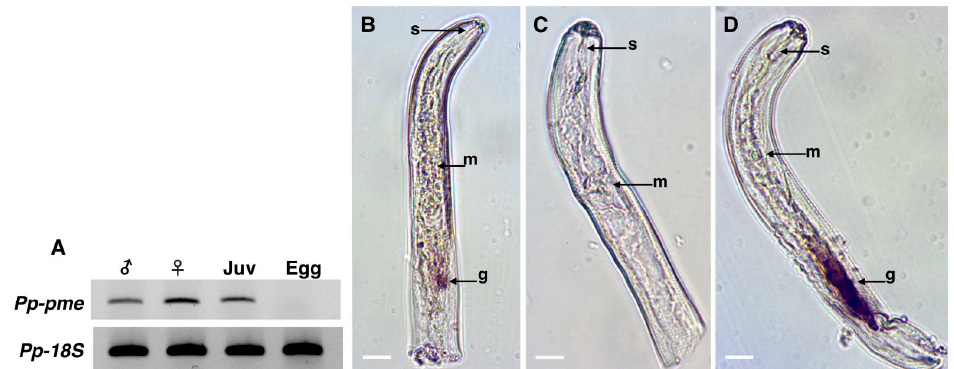
Fig 5. Expression and localization of Pratylenchus penetrans Pp-pme transcripts. (A) Determination of Pp-pme expression in different nematode developmental stages of P . penetrans by semi-quantitative RT-PCR. As a positive control, all cDNA templates were amplified with primers derived from the 18S gene of P . penetrans . The nematode stages were separated as males, females, juveniles (J2-J4), and eggs. (B-C) Detection of the Pp-pme transcripts by in situ hybridization. Nematode sections were hybridized with antisense (B), or sense (C) Pp-pme digoxigenin-labeled cDNA probes. (D) As a positive control, in situ hybridization was performed with the antisense probe designed for the CWDE ( Pp-eng-1 ) specifically localized within the esophageal glands g: esophageal glands; m: metacorpus; s: stylet.